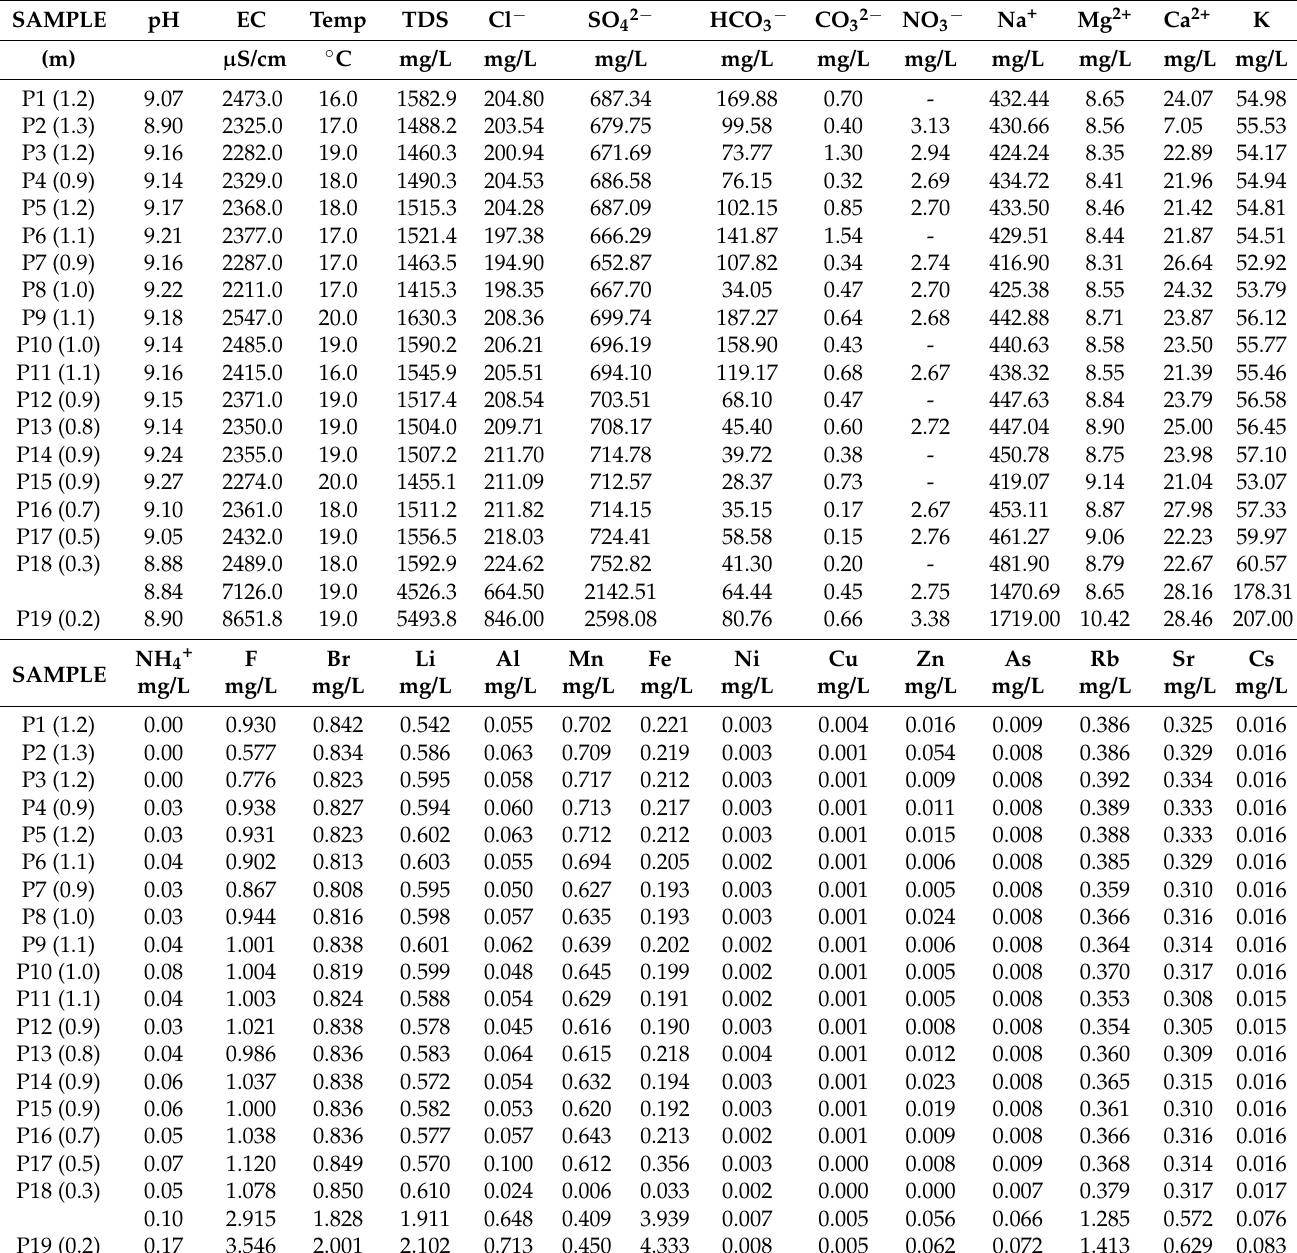
Table 1. Water sampling points in Sochagota Lake. M: medium vertical